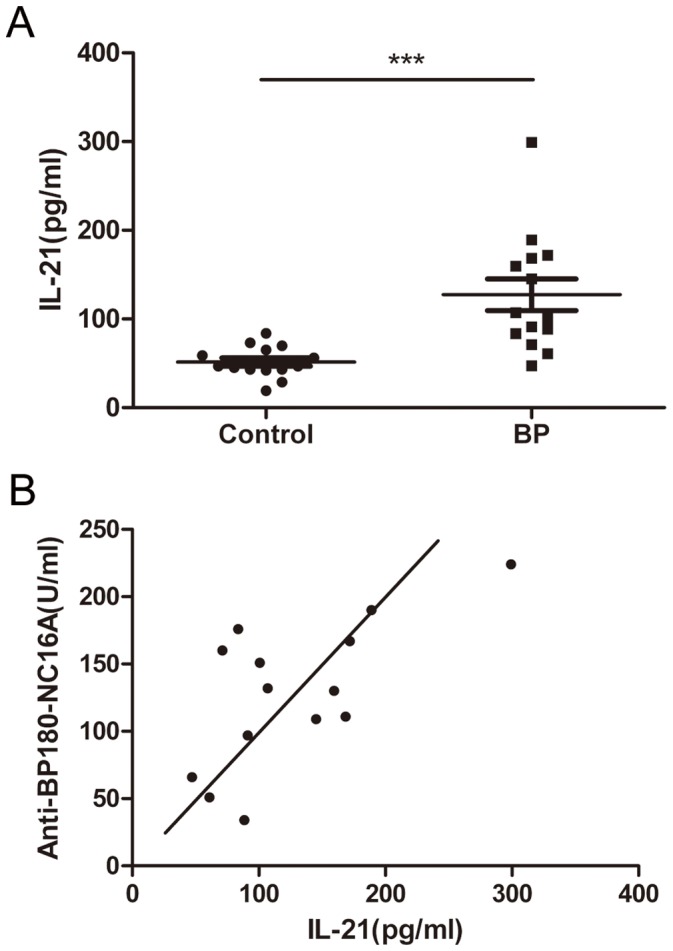
IL-21 levels in the sera of BP patients and healthy controls.(A) IL-21 levels in the sera of 14 BP patients and 14 age-matched and sex-matched healthy controls. Each data point represents an individual subject; horizontal lines show the 25th percentile, the median, and the 75th percentile. (B) The correlation between the IL-21 levels and the anti-BP180-NC16A autoantibody titers of 14 BP patients. Each data point represents an individual subject. ***P<0.001.